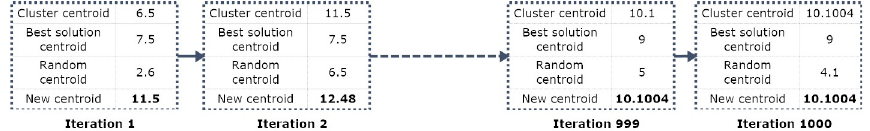
Fig 7. Example of the adaptive DE strategy performed on a cluster centroid of value 6.5 throughout 1000 iterations.